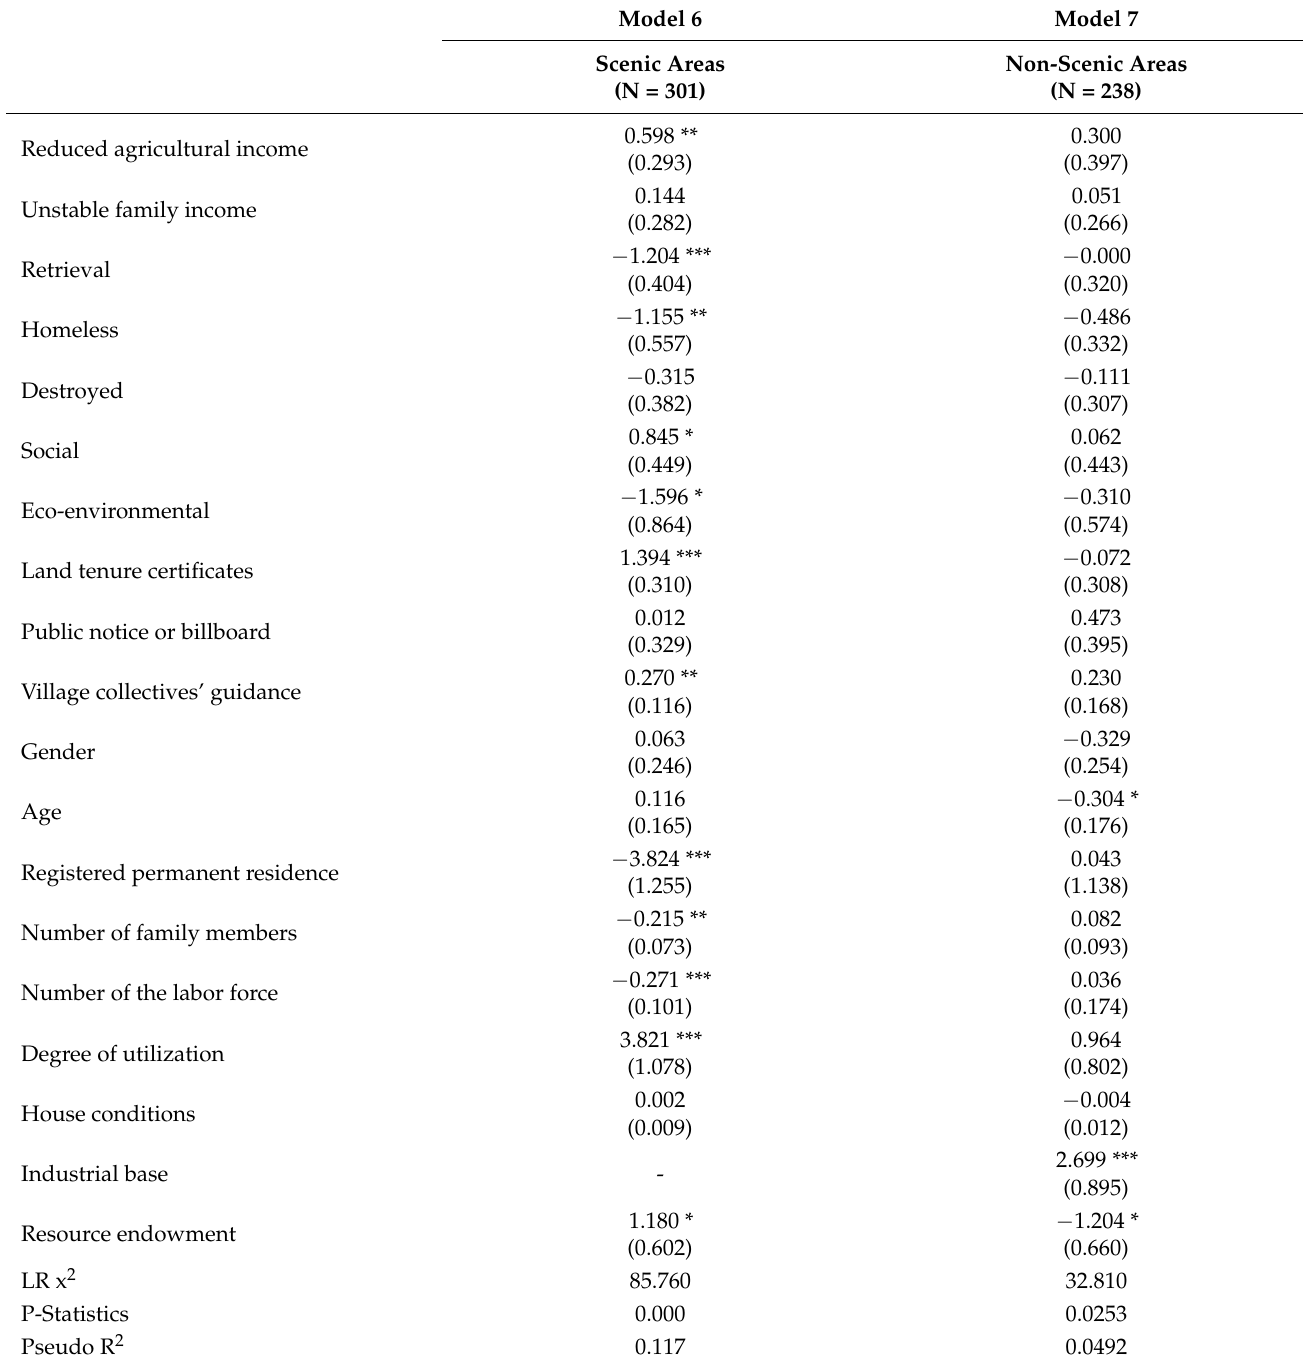
Table 5. Heterogeneity analysis of location